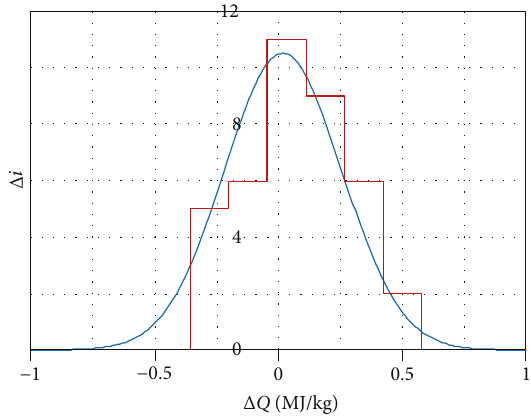
Figure 7: Histogram of Δ Q = Q b − Q p . Solid line — Gaussian fi t for data points. The width of Gaussian curve (standard deviation (SD)) is